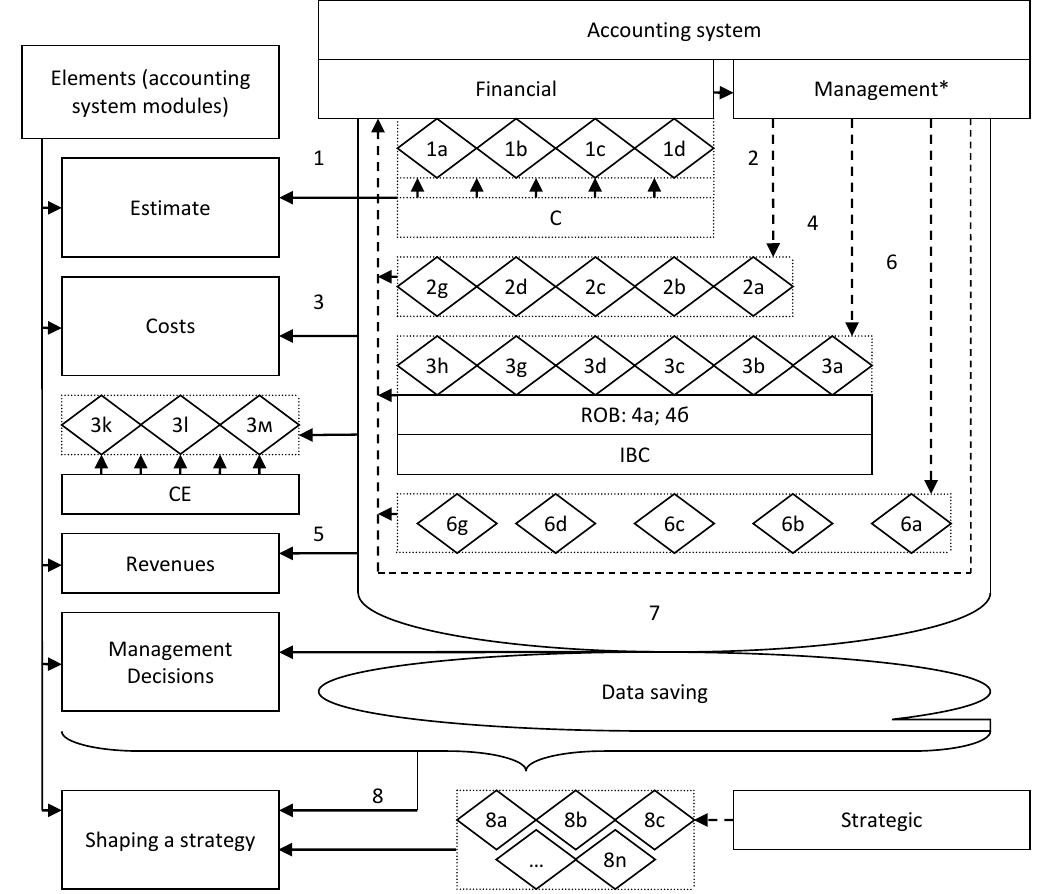
Figure 3. The general scheme of modules interconnection of accounting system in budgetary